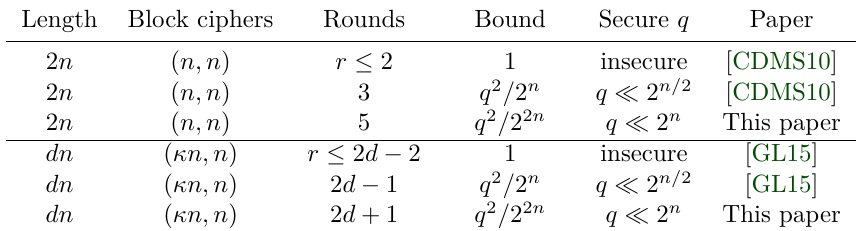
Table 1: Summary of our result and results in [CDMS10] and [GL15]. Here, κ , d , and ‘ are positive integers with d = κ + 1 and 1 column of block ciphers denotes n -bit block ciphers with k -bit keys and the bounds neglect constants.